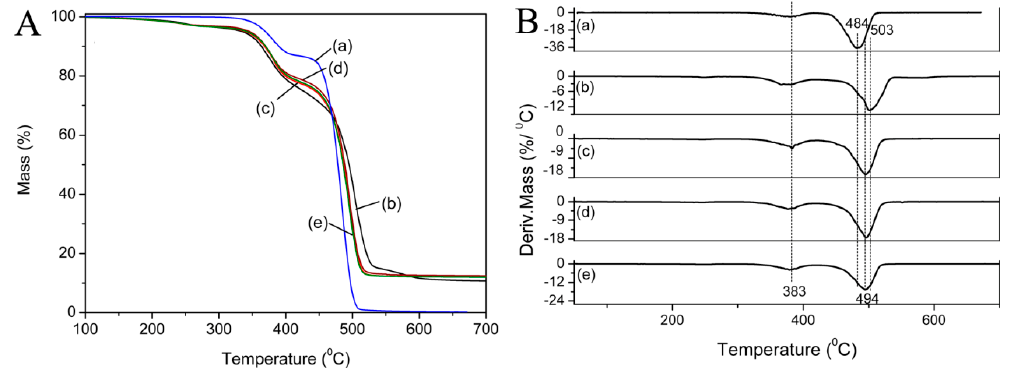
Figure 6. A : TGA and B : DTG curves for ethylene vinyl acetate (EVA) and composites. ( a ) EVA, ( b )